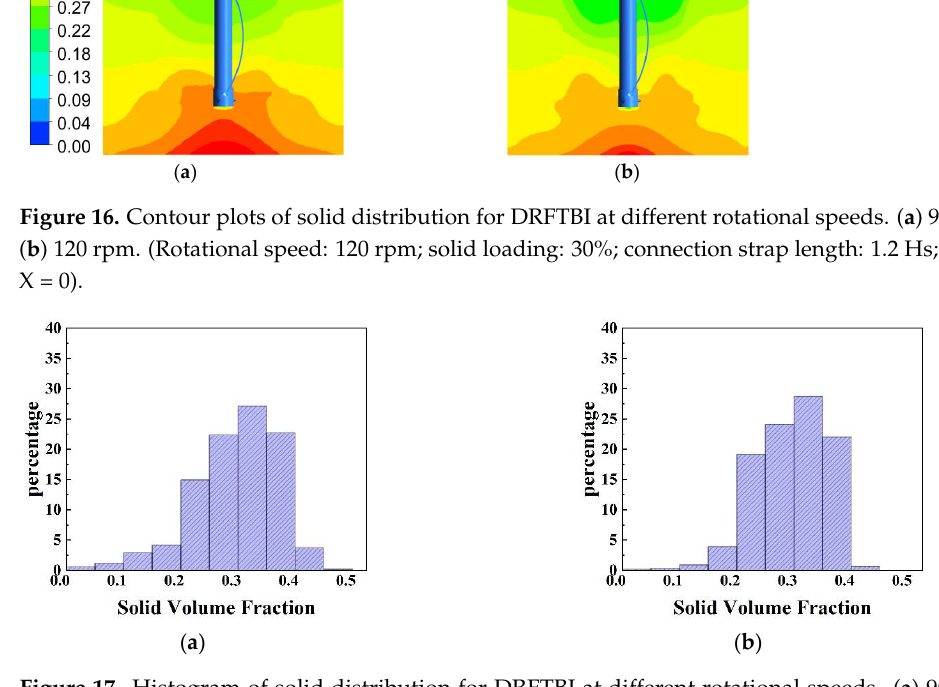
Figure 17. Histogram of solid distribution for DRFTBI at different rotational speeds. ( a ) 90 rpm; ( b ) 120 rpm. (Rotational speed: 120 rpm; solid loading: 30%; connection strap length: 1.2 Hs.)